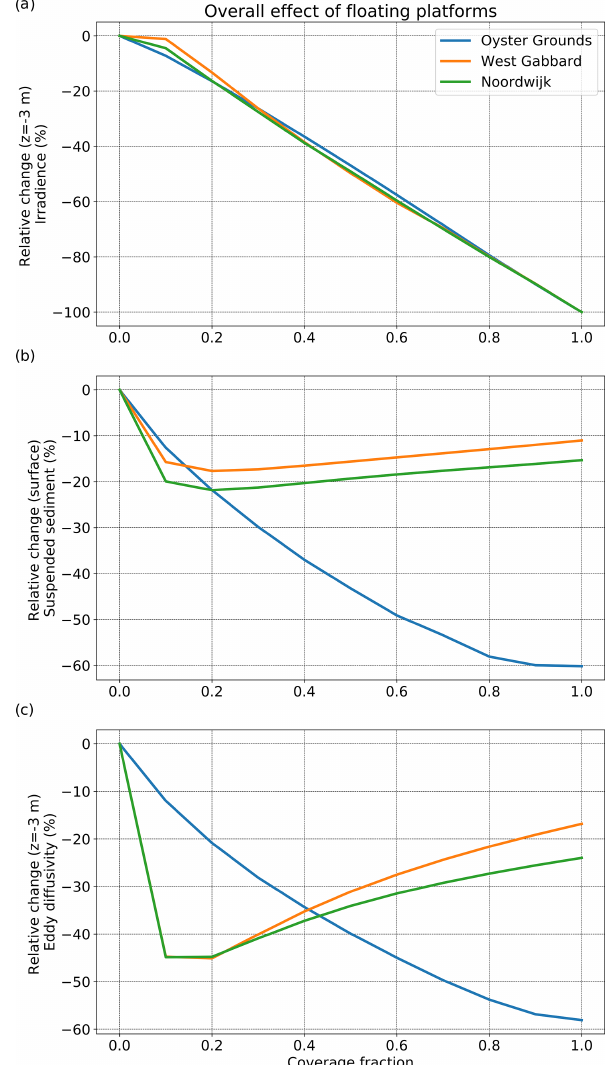
Figure 5. Relative change against the reference of (a) irradiance at 3m depth, (b) suspended sediment at the surface and (c) eddy diffu- sivity at 3m depth. The results are presented for increasing values of coverage under the overall effect of floating platforms for the three locations of the